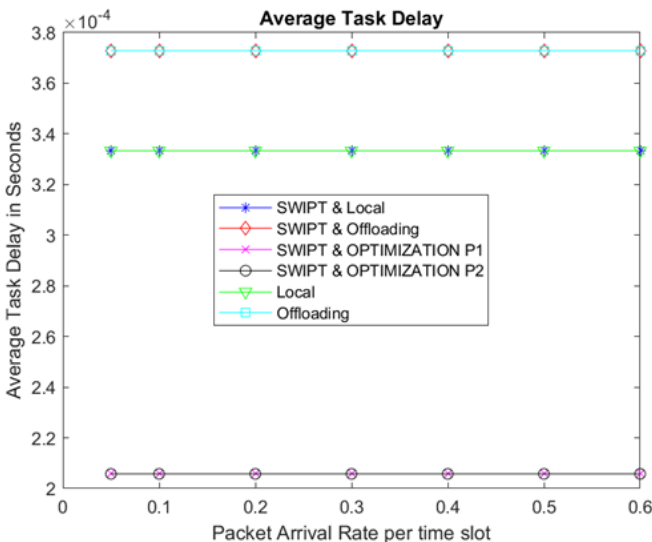
Figure 17. Average task delay of the end node with variable packet arrival rate.